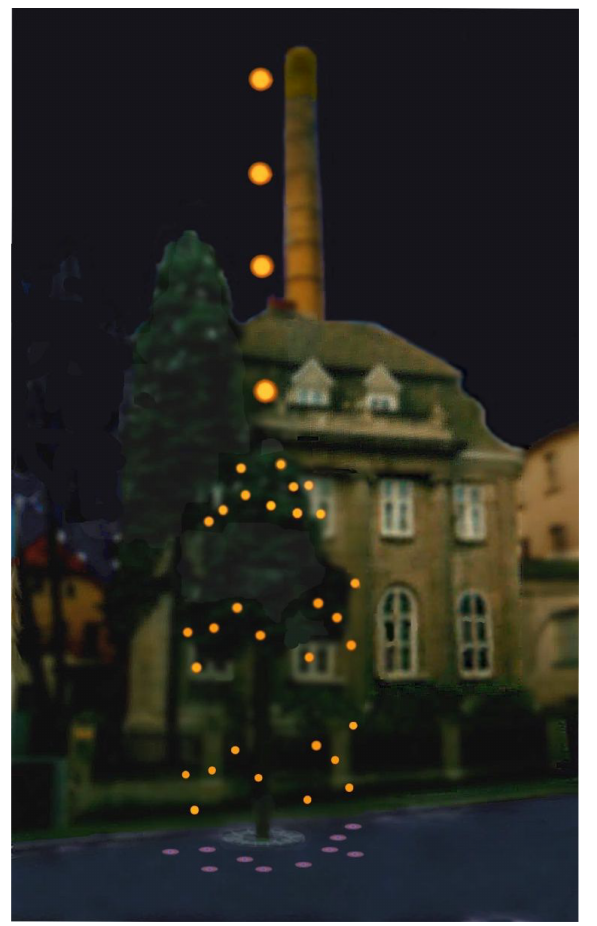
Figure 3. Synopsis of Wittmann’s observation, 1951, by the witness – falling main object, fragmentation into smaller spheres, and their street impact. Computer simulation based on an original photograph of the site: Axel